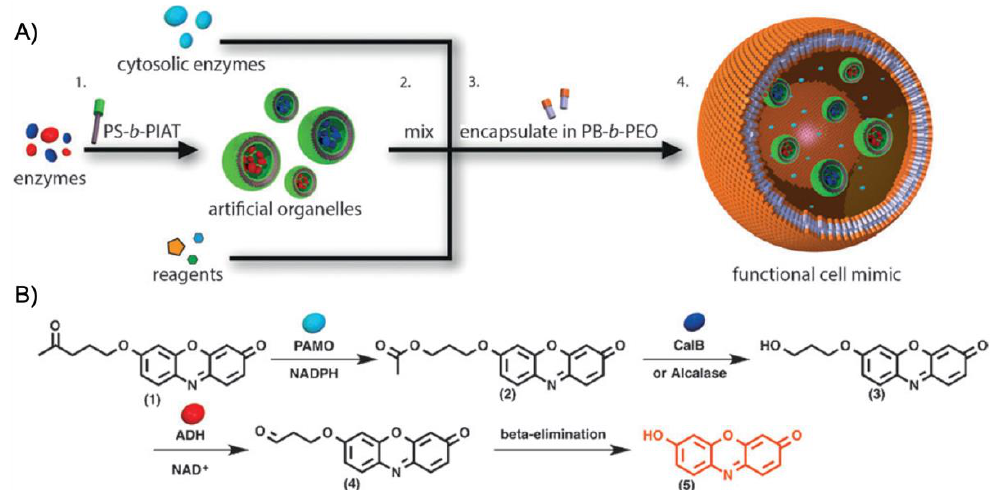
Figure 18. Enzymatic cascade reaction in a polymersome-in-polymersome system. ( A ) Schematic illustration of the encapsulation of the enzymes CalB and ADH in PS- b -PIAT polymersomes and subsequently encapsulated by PEO- b -PB along with PAMO and substrates in giant polymersomes. ( B ) Four-step cascade reaction of profluorescent 7-((4-oxopentyl)oxy)-3H-phenoxazin-3-one to the fluorescent 7-hydroxy-3H-phenoxazin-3-one. Reproduced with permission of [149]. Copyright 2014 Wiley-VCH.